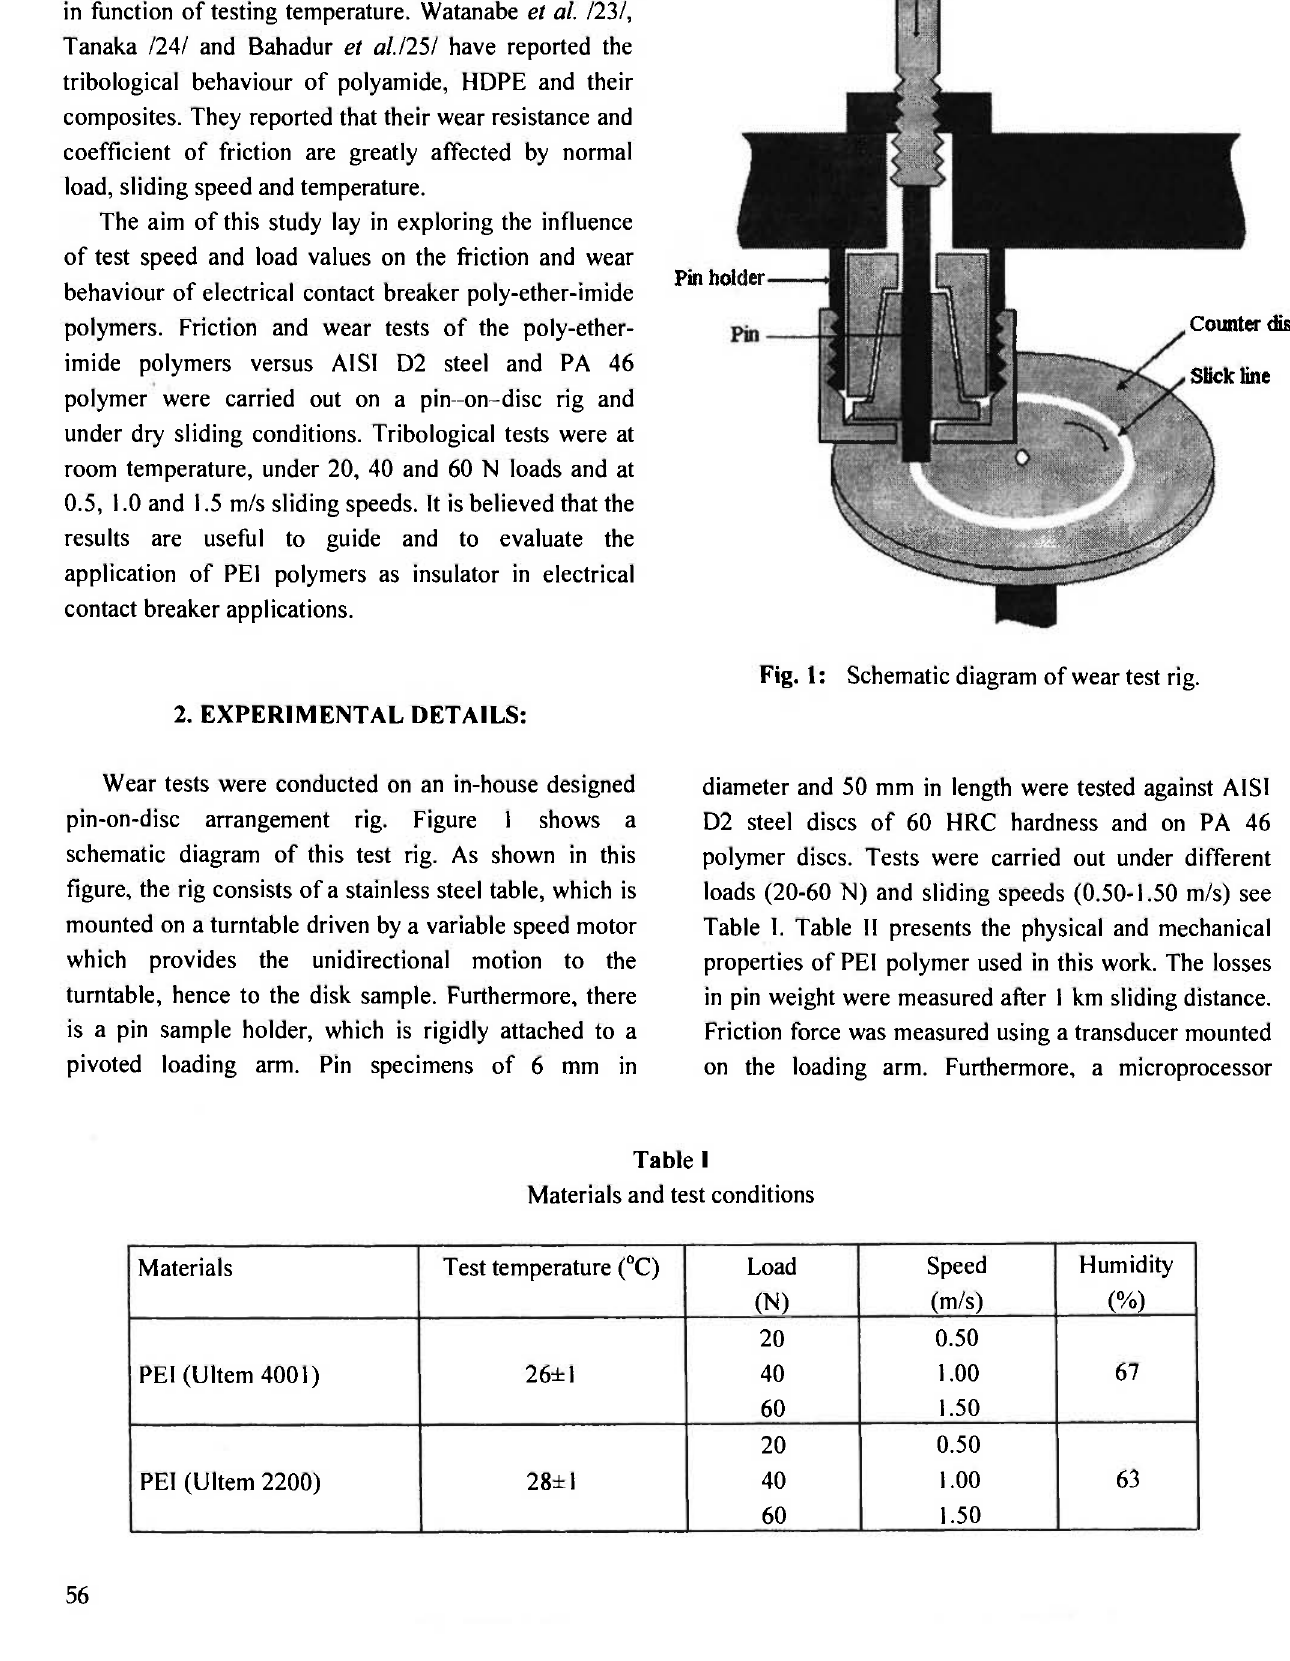
Fig. 1 : Schematic diagram of wear test rig.